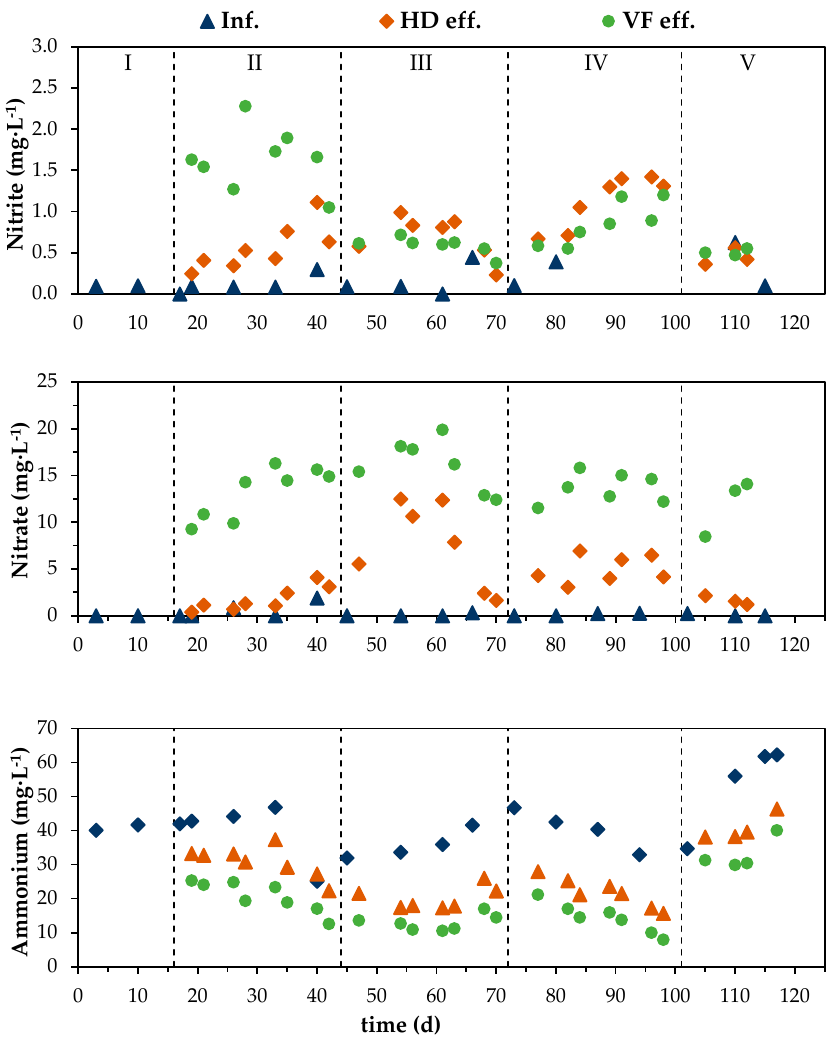
Figure 3. Concentration of nitrogen compounds in raw influent and effluent of HD and VF units. Acronyms: Inf = municipal wastewater influent; HD eff = hybrid digester effluent; VF eff = vertical flow constructed wetland effluent.